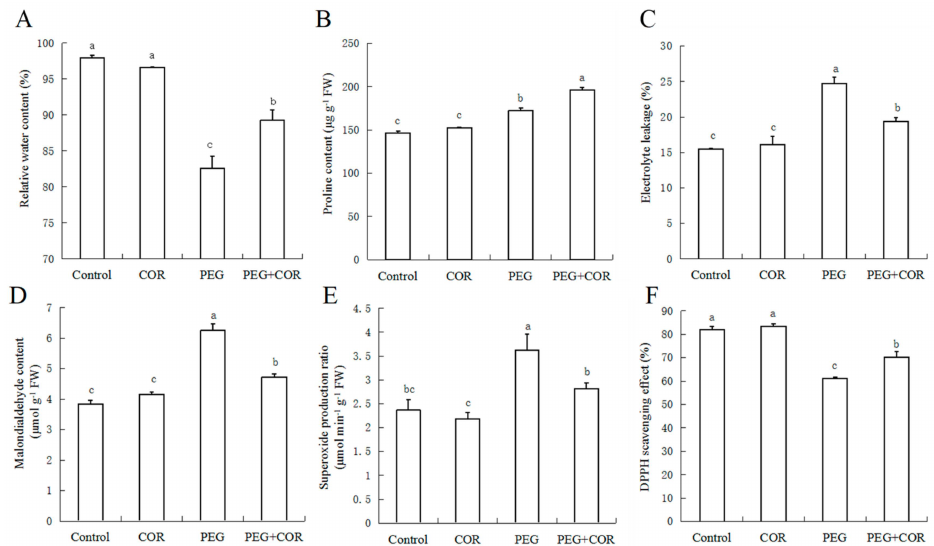
Figure 2. E ff ects of cornatine on relative water content ( A ), proline content ( B ), electrolyte leakage ( C ), MDA content ( D ), superoxide production ratio ( E ) and DPPH scavenging activity ( F ) in leaves of rice seedlings under drought condition at 3 d. Values are means of four experiments each with three replications; bars with di ff erent letters are significantly di ff erent ( p < 0.05). FW, fresh